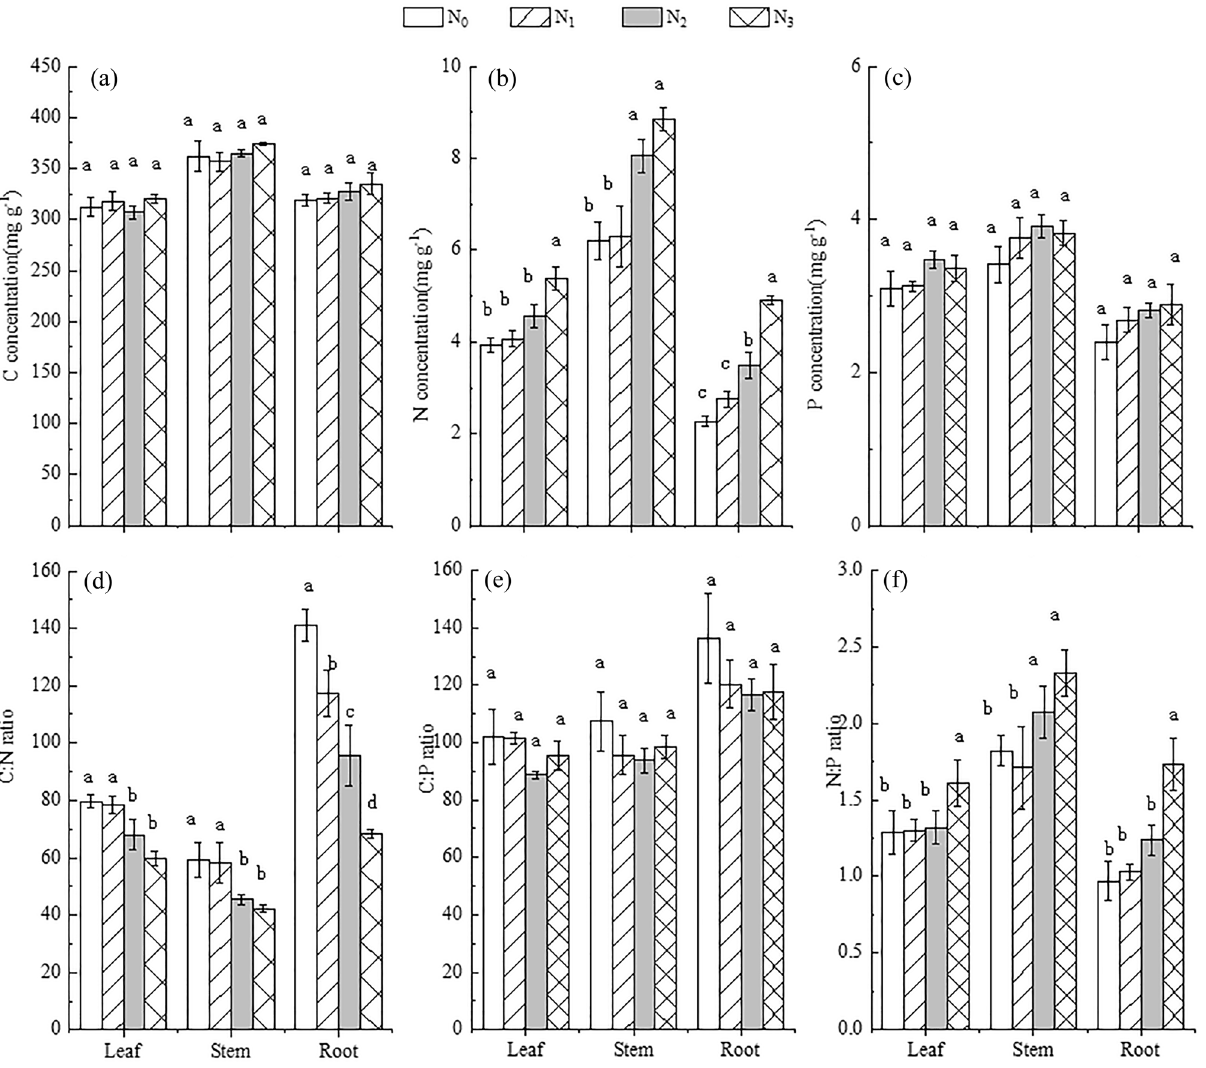
Figure 3. Effects of N addition on plant biomass, C, N, and P concentrations, and the stoichiometric ratios of C:N, C:P, and N:P in R. soongorica . Error bars represent SE (n = 6). Different lowercase letters above bars indicate significant differences at P < 0.05.